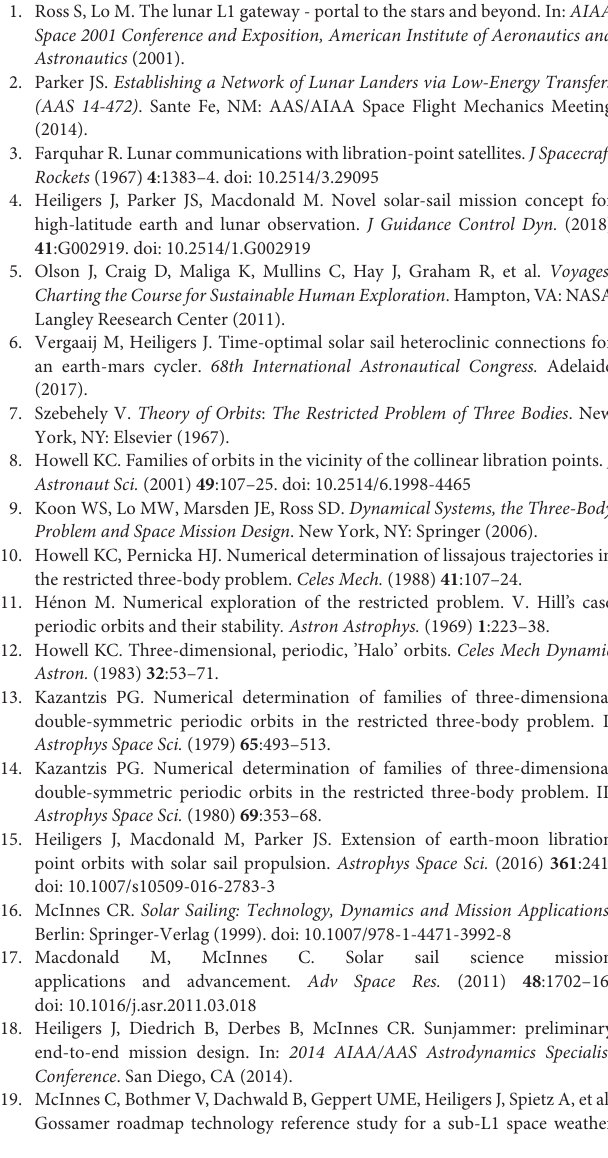
spatial, three-dimensional